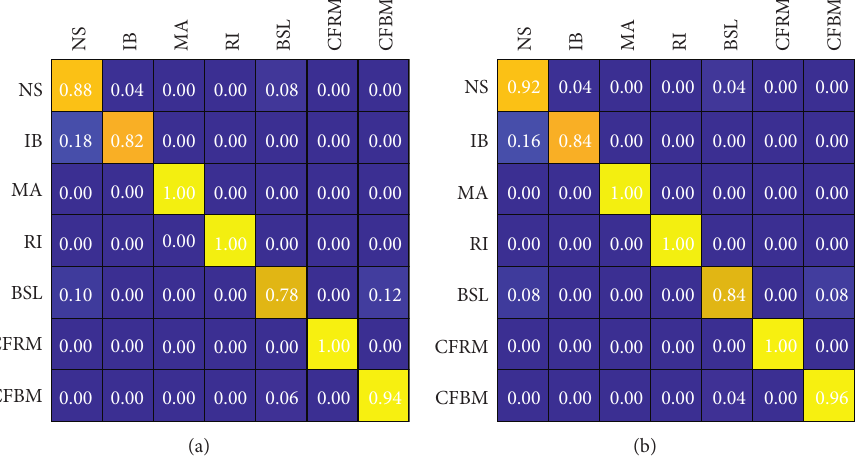
Figure 9: Classification result by infrared images. (a) Original infrared images. (b) Enhanced infrared